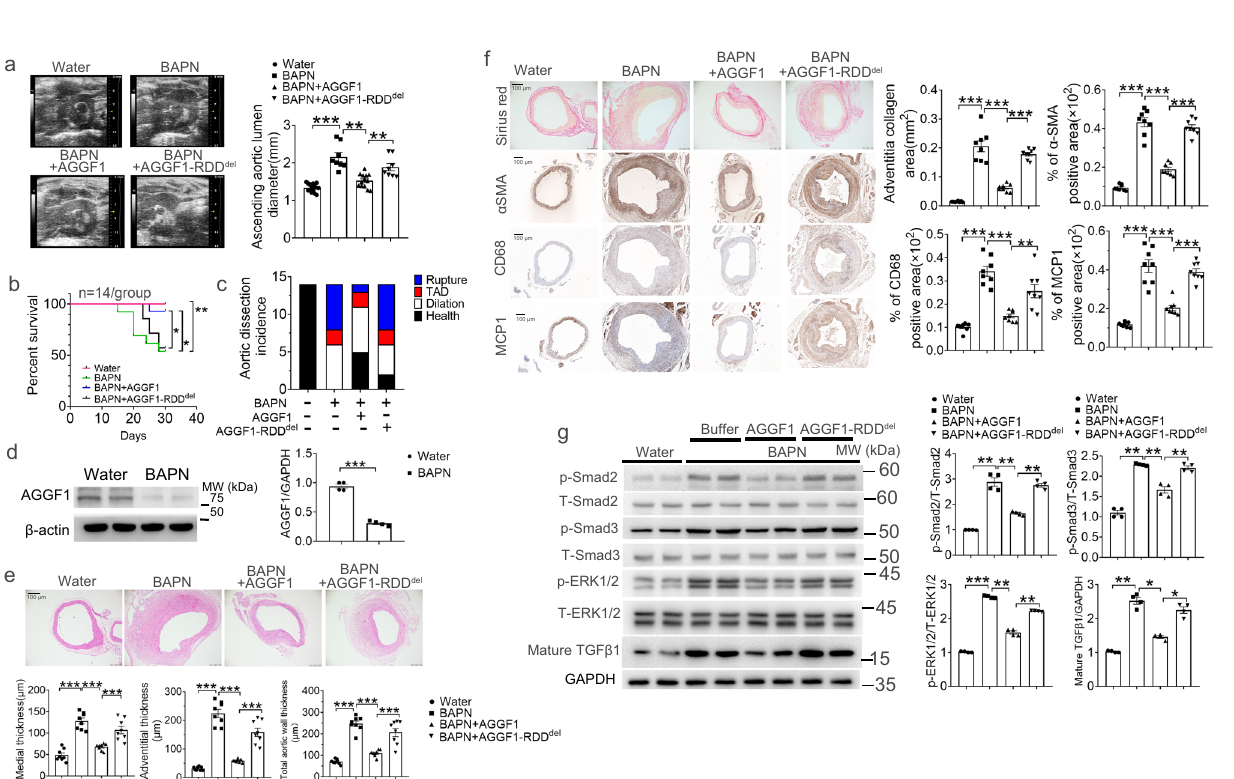
Fig. 9 | AGGF1 blocks arterial remodeling, in fl ammation, and TGF- β 1 signaling in a BAPN-induced model for aortic aneurysms in male mice. a Mean lumen diameter of the ascending aortas from four groups of male mice (control mice fed withwater,BAPN-fedmicetreatedwithPBSbuffer,BAPN-fedmicetreatedwithwild type AGGF1, and BAPN-fed mice treated with mutant AGGF1 with a deletion of the RDD motif ( n =14, 8, 13, and 8 mice). b Kaplan-Meier survival curves and statistical analysisusingalog-ranktest. c Ratiosofmicewiththoracicaorticdissection(TAD),